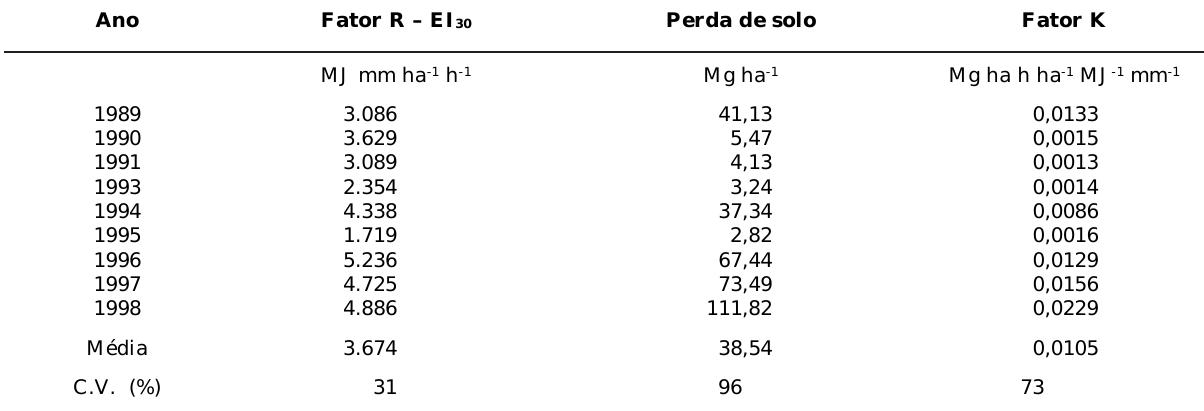
Quadro 2. Valores médios estacionais do fator erosividade – EI (média de duas repetições) e fator erodibilidade (fator K) determinados pelo quociente entre a média das perdas de solo e a média das erosividades das chuvas, do Cambissolo Húmico alumínico léptico em Lages (SC), na primavera-verão de 1989 a 1998